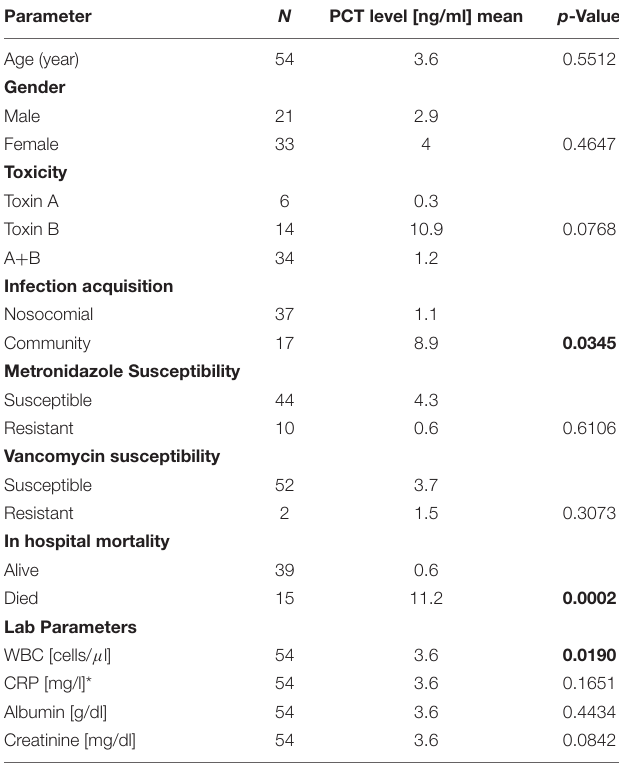
TABLE 3 | Correlation analysis between PCT and demographics and clinical parameters of CDI